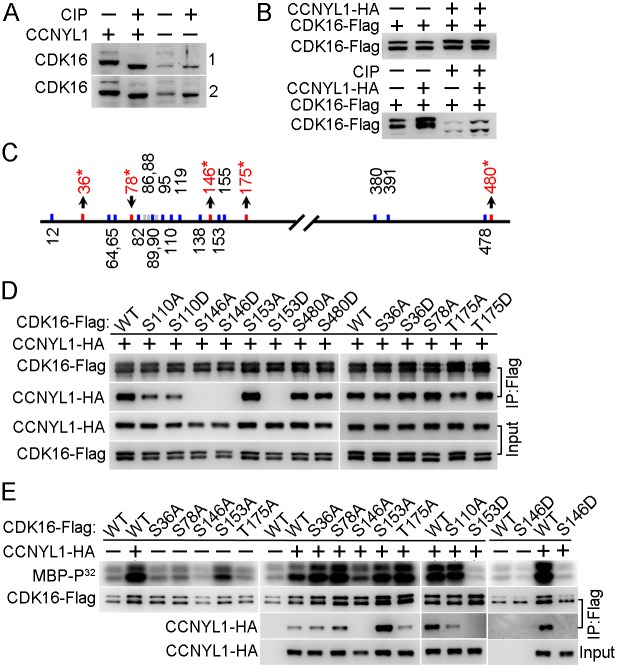
Identification and functional study of phosphorylation modifications of CDK16.(A) Testicular lysates from two pairs of WT and Ccnyl1-/- mice were incubated with or without calf intestinal phosphatase (CIP) at 37°C for 30 min and analyzed by western blotting. (B) CDK16-Flag was either expressed alone or together with CCNYL1-HA in HEK293T cells. The cell lysates were incubated with or without CIP, and analyzed by western blotting. (C) Phosphorylation sites on CDK16 identified by mass spectrometry. Sites that changed significantly in phosphorylation levels between single- (CDK16-Flag) and double- (CDK16-Flag and CCNYL1-HA) expressed groups are labeled red with asterisks. (D) Various CDK16-Flag mutants were coexpressed with CCNYL1-HA in HEK293T cells. The interactions were analyzed by CoIP experiments followed by western blot. (E) Varies CDK16-Flag mutants were either expressed alone or coexpressed with CCNYL1-HA in HEK293T cells. The CDK16-Flag protein was immunoprecipitated, and incubated with MBP as substrate in the kinase buffer. Reaction products were separated by SDS-PAGE and followed by autoradiography.